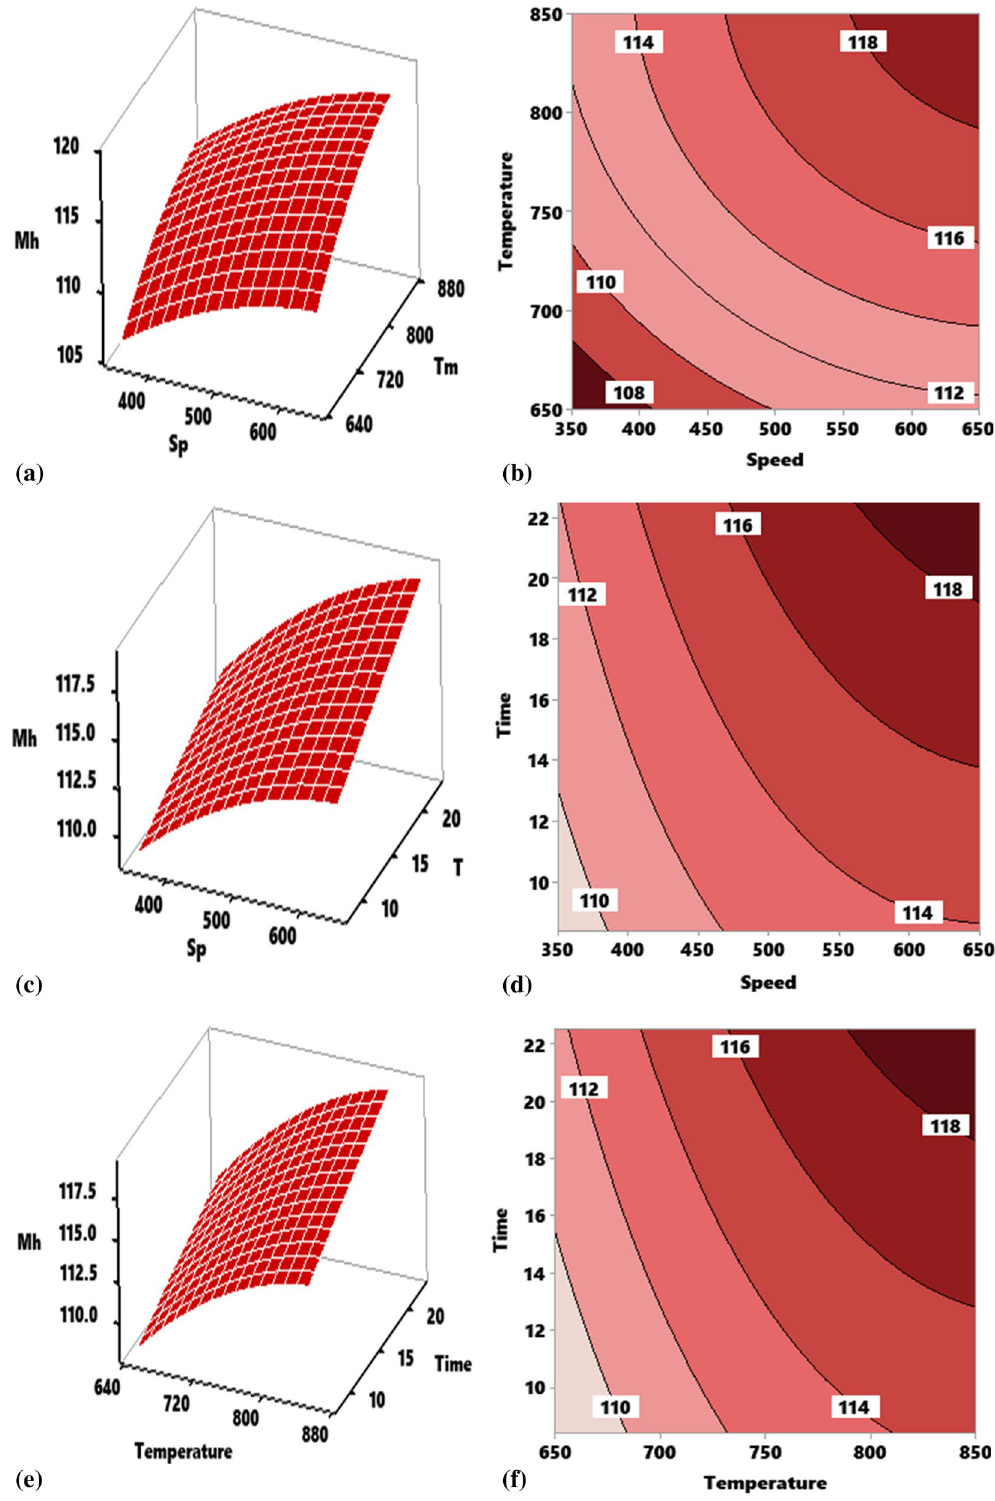
Figure 4. Influence of stirring parameter on microhardness of developed composite as represented by response surface plot and contour plot for interactions. ( a , b ) Speed and temperature, ( c , d ) speed and time, ( e , f ) temperature and